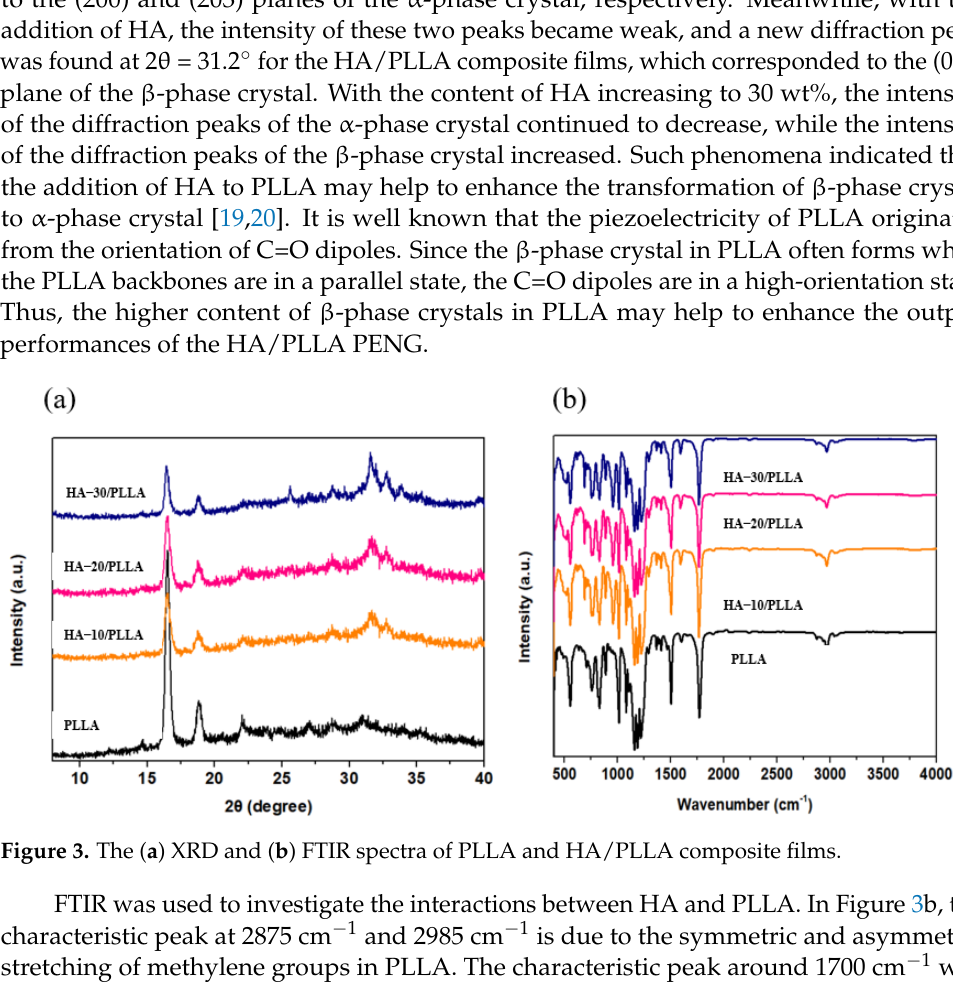
Figure 4. Cross-section SEM images of HA/PLLA composite film (20 wt%). The output performances of the HA/PLLA PENGs are provided in Figure 5. Under the same impact conditions, the PLLA PENG output only 1 mV voltage. With the addition of HA to PLLA, the output voltage improved significantly, reaching the maximum voltage of ~3.4 mV when the HA content was 20%, which was over three times that of the pure- PLLA PENG. According to the XRD and FTIR analysis, the addition of HA to PLLA may help to form β -phase crystals and hydrogen bonds between PLLA and HA, which may improve the piezoelectric output of the HA/PLLA PENGs. However, with further increase